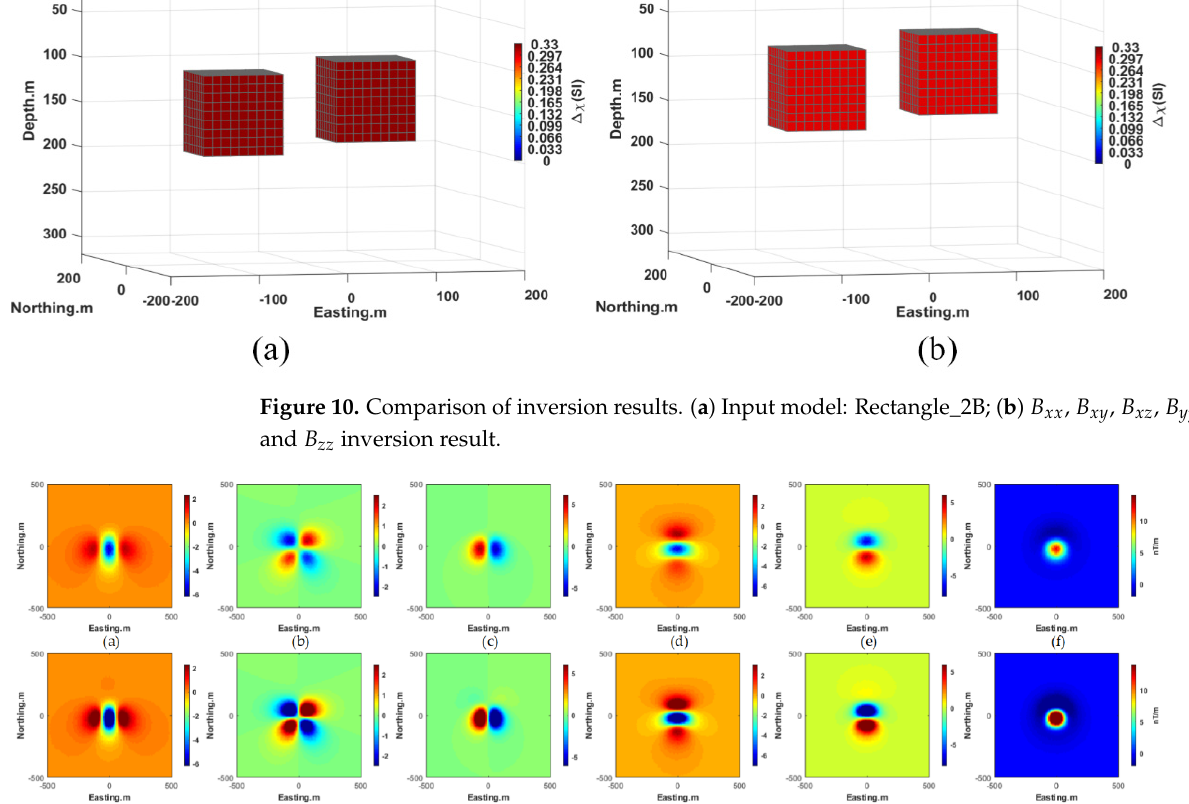
Figure 11. Comparison of the Rectangle model’s components and prediction model’s components.